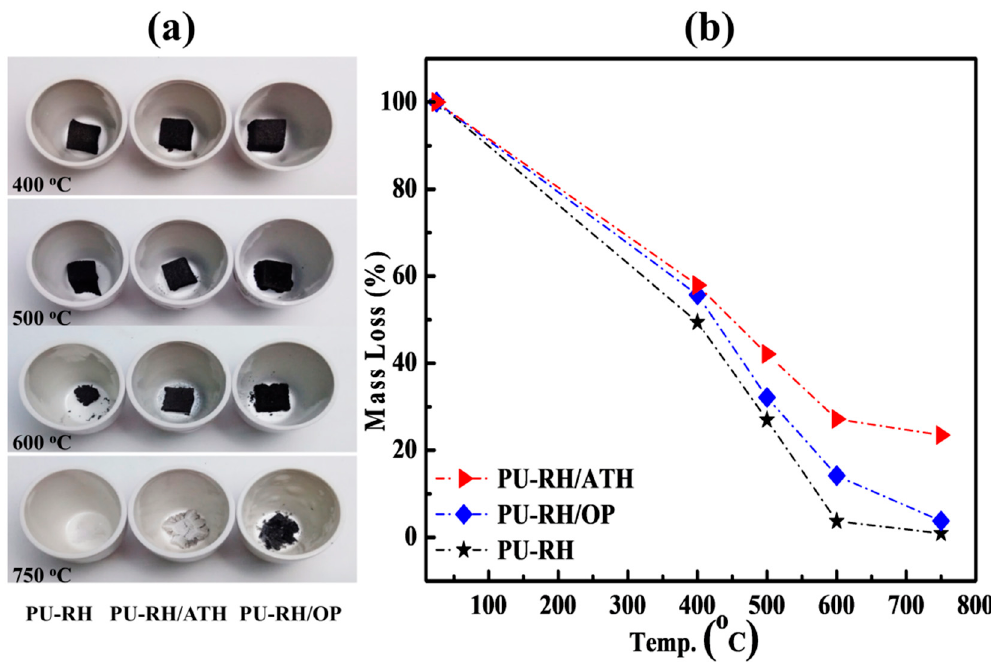
Figure 5. ( a ) Photographs of the char residues of PU–RH, PU–RH/ATH, and PU–RH/OP and ( b ) mass loss curves after the incinerations in the furnace at different temperatures.